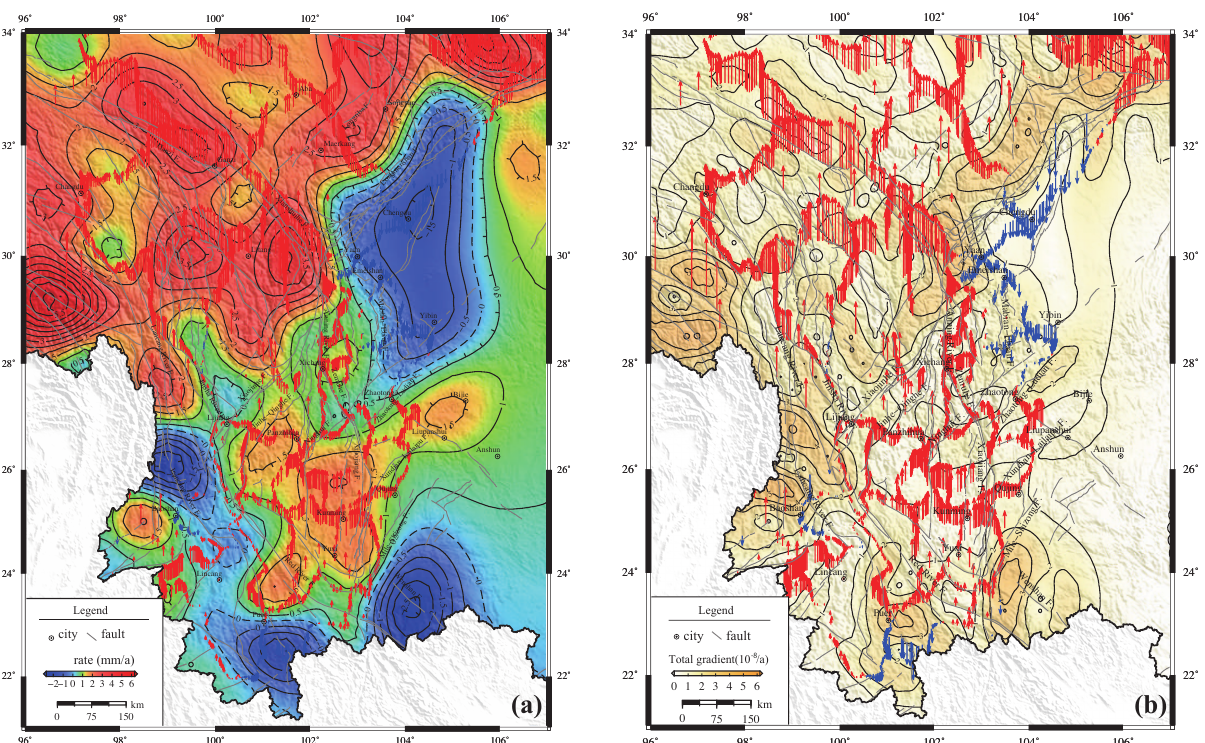
Figure 5. ( a ) Contour and ( b ) gradient map of the vertical motion velocity in the eastern margin of the Qinghai–Tibet Plateau and its surrounding areas. Solid black lines indicate the contours of vertical motion velocities in ( a ) and gradients in ( b ). The blue and red arrows are the vertical velocity after fusing the GNSS and the leveling data,